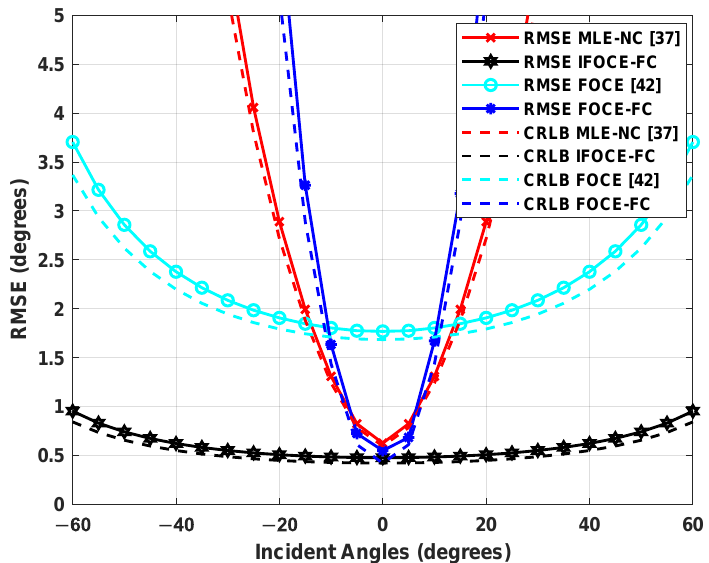
Figure 11. Comparison of different algorithms for the RMSE and corresponding CRLB versus the incident angle under spatially colored noises in the ULA